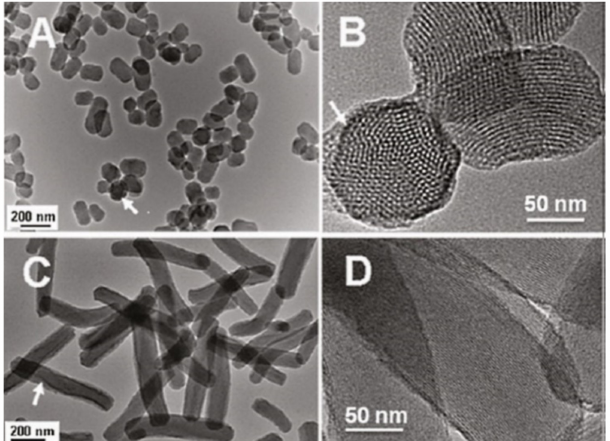
Figure 10. Characterization of short rod MSN labeled with FITC (NSRFITC) and long rod MSN labeled FITC (NLRFITC). ( A ) TEM image of NSRFITC. ( B ) TEM image showing the mesostructure of NSRFITC. ( C ) TEM image of NLRFITC. ( D ) TEM image showing the mesostructure of NLRFITC. Arrows denote FITC embedded in a particle. Reproduced with permission from [30], American Chemical Society, 2011.